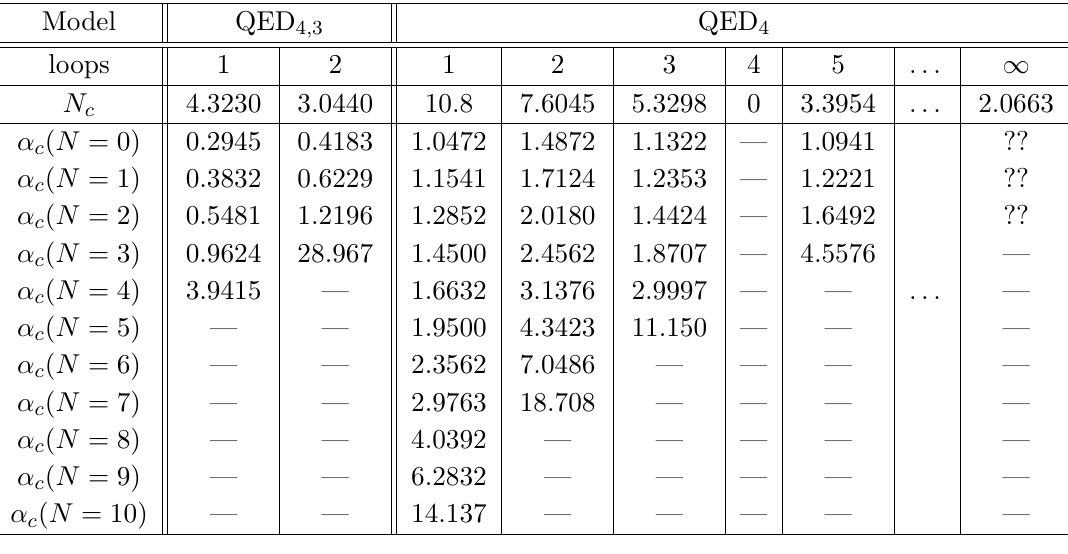
Table 3 : Critical couplings of unquenched QED gether with the effective dynamical coupling (4.17) up to 5 loops (the symbol “—” indicates that no physical solution is found and the symbol “??” indicates that we could not compute the corresponding